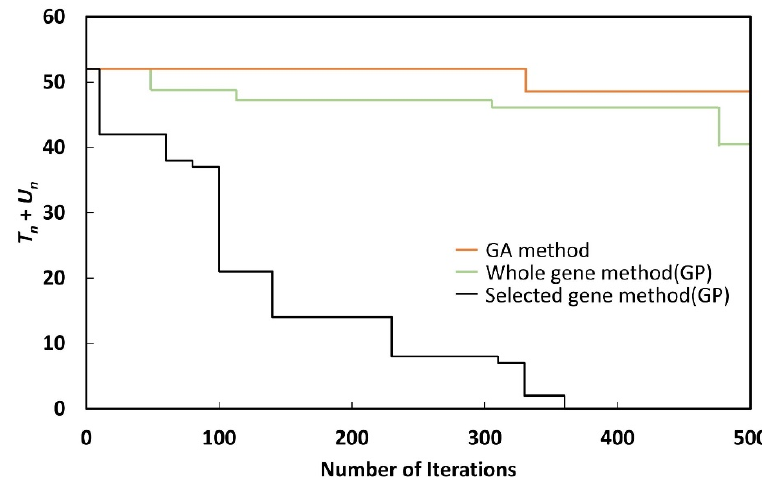
Figure 14. GP results for the minimized fitness function (2023).